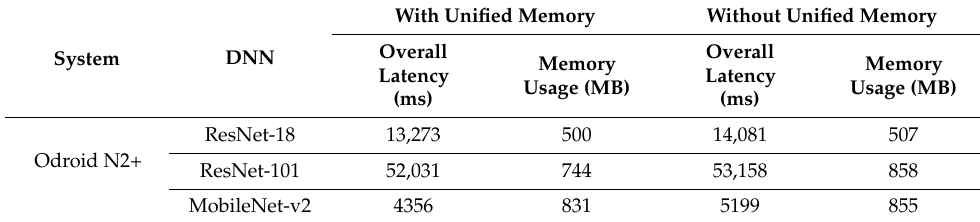
Table A1. Comparison of performance with and without unified